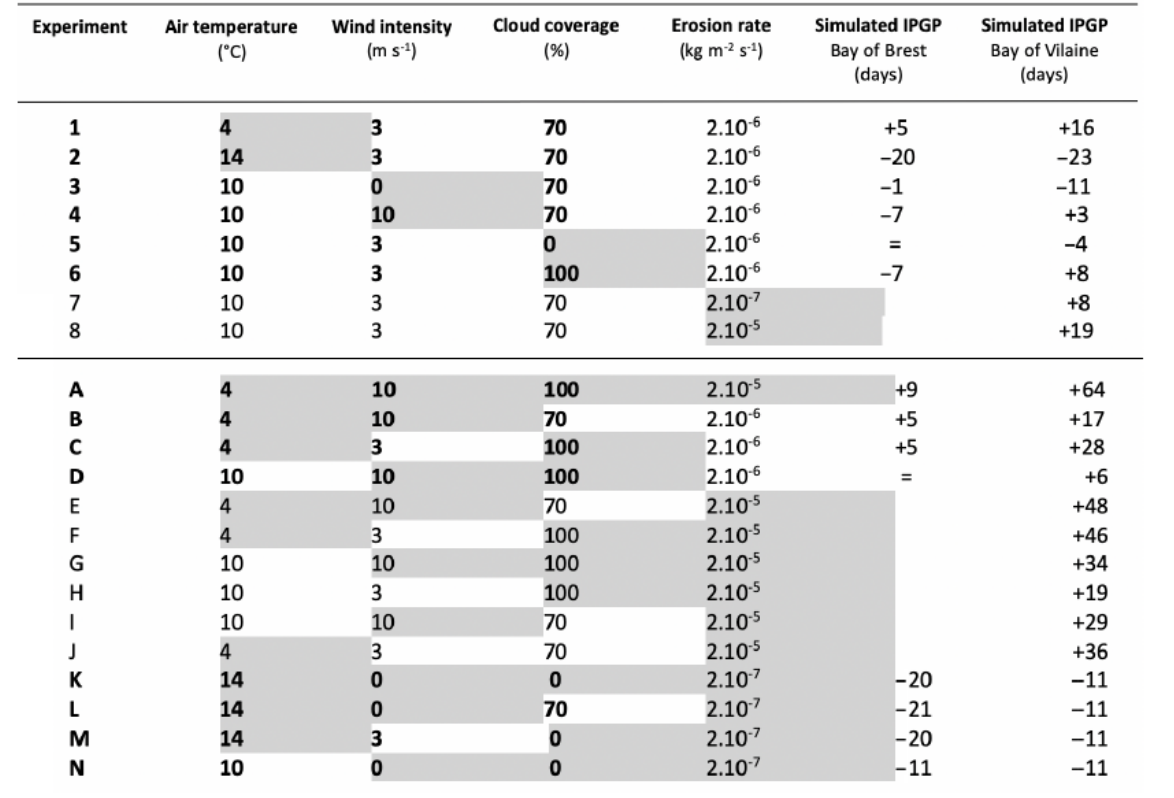
Table 5. Assumptions are explored in the 1DV model for environmental parameters independently (1–8) and with a combined effect (A–N) with the modified values (grey background) and text in bold for the Bay of Brest only ( + for a later IPGP, − for an earlier IPGP, = for an equal IPGP) with the IPGP equal to the mean observed IPGP of day